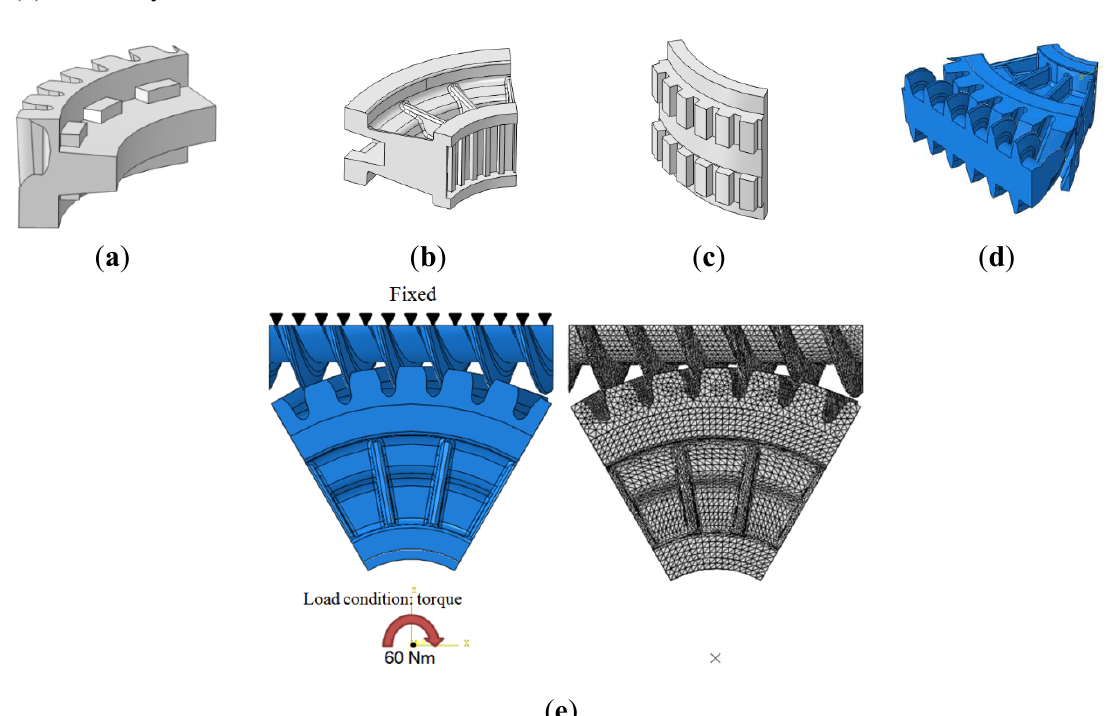
Figure 3. Assemble model for strain-stress CAE analysis. ( a ) tooth form part; ( b ) middle locking part; ( c ) end part; ( d ) tooth, middle locking, end parts and worm gear